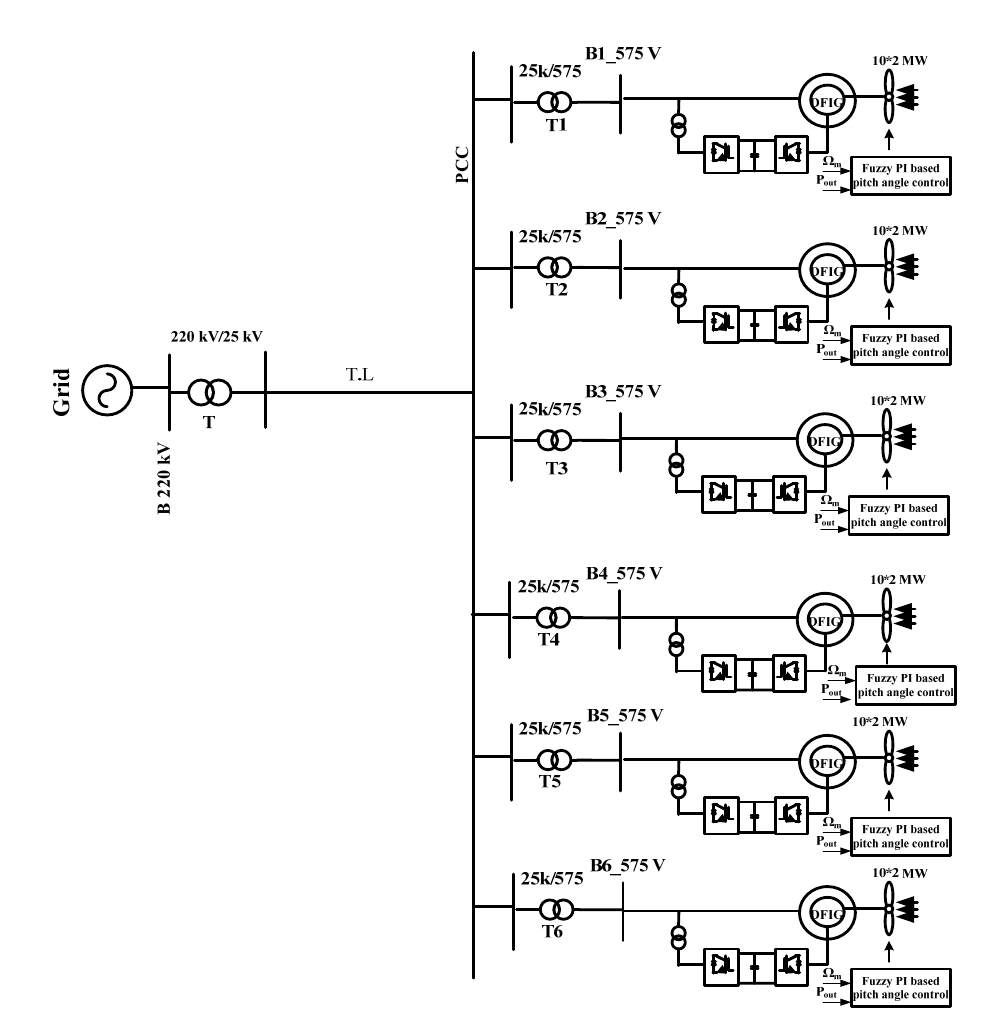
Figure 9. Large-scale wind farm model configuration.